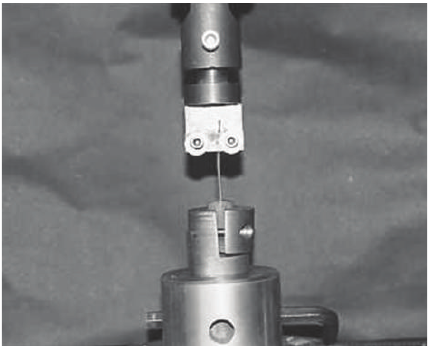
Figure 2: Measurement of stem tensile strength using an Instron 1122 test